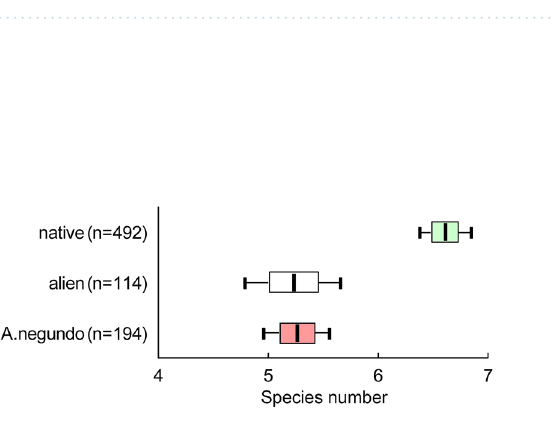
Figure 5. Average rates (± SE, ± 95CI) of species’ number per 400 m 2 in communities dominated by Acer negundo (An+ ; pink plots) and other tree species (An− ; green plots).